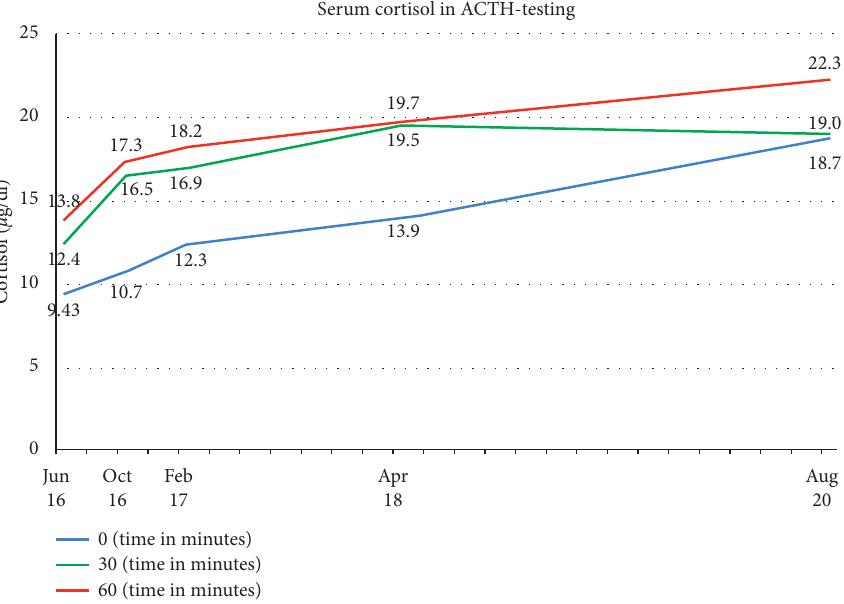
Figure 3: Course of serum cortisol in repetitive ACTH testing from June 2016 to August 2020 (x-axis). The blue lines stand for the basal serum cortisol level, the green line represents the serum levels 30 minutes after ACTH stimulation, and the red line represents the serum levels 60 minutes after ACTH